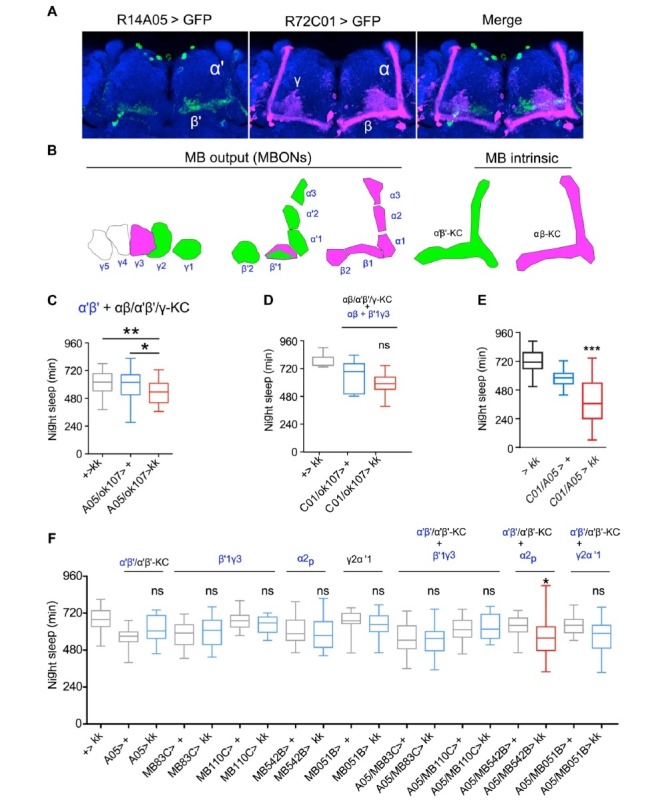
Modestcontribution of MB output neurons (MBONs) to NCA-mediated sleep.(A) Confocal stacks labelling R14A05- (A05, green) and R72C01- (C01, magenta) positive neurons. Images are from (Jenett et al., 2012) and deposited at Virtual Fly Brain (www.virtualflybrain.org). Images were downloaded and digitally superimposed (Merged) onto a standardised fly brain (active zones are labelled in blue using the nc82 antibody; the image source data is distributed under a CC BY-NC-SA 4.0 license). (B) Tiling scheme of MBONs adapted from (Aso et al., 2014). The A05- (green) and C01-Gal4 (magenta) drivers potentially label complementary parts of MBONs (blue letters), though there is potential limited overlap within the β’1 region. C01-Gal4 clearly labels the αβ lobe of MB intrinsic Kenyon cells αβ-KC, black letters), while A05-Gal4 labels α’β’-KC. (C) Simultaneous Nca knockdown in A05-neurons (potentially including α’β’-KC and α’β’-MBONs) and all KC neurons (using ok107Gal4) results in limited night sleep loss. (D) Simultaneous Nca knockdown in C01-neurons (including αβ-KC and γ3-MBONs) and all KC neurons (using ok107-Gal4) did not result in significant night sleep loss. (E) Nca knockdown in both A05- and C01-positive neurons results in robust night sleep loss. For (C-E), please see Figure 5—figure supplement 2G for nvalues. (F) Knockdown of Nca in A05-neurons (which potentially include α’β’-KCs and α’β’MBONs) and in 3 distinct MBON regions potentially labelled by A05-Gal4 (γ2α’1) or C01-Gal4 (β’1γ3 and α2p) does not cause sleep loss. Simultaneous Nca knockdown in both A05-neurons and in α2p MBONs results in modest sleep loss (A05/MB542B > kk, red). In contrast, no sleep reduction was observed following Nca knockdown in A05 (β’1γ3 MBON or A05/γ2α’1 MBONs. n = 16-28. *p < 0.05, **p < 0.01, ***p < 0.001, ns – p > 0.05, compared to driver and RNAi alone controls by Kruskal-Wallis test with Dunn’s post-hoc test.